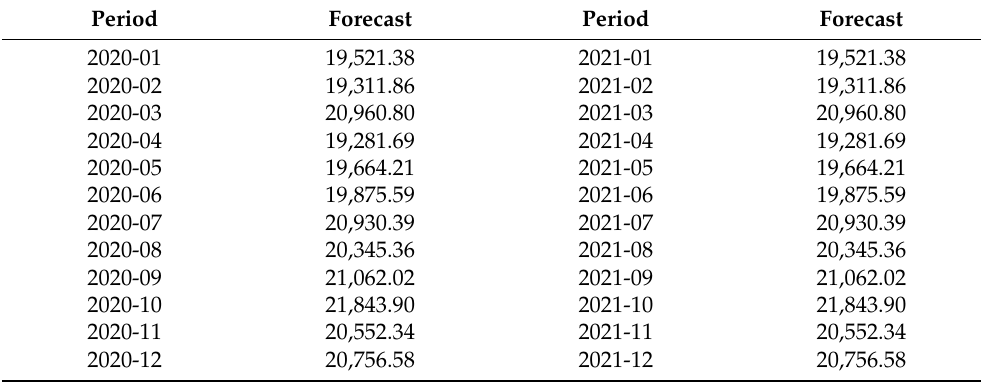
Figure 6. Exponential smoothing of gas oil and diesel oil supplies. Source: own elaboration. The values of the forecasts obtained on the basis of this are presented in Table 3, and the forecast errors are in Table 4. Table 3. Monthly gas oil and diesel oil supply forecasts for 2020–2021 (in thousand tonnes). Source: own elaboration.